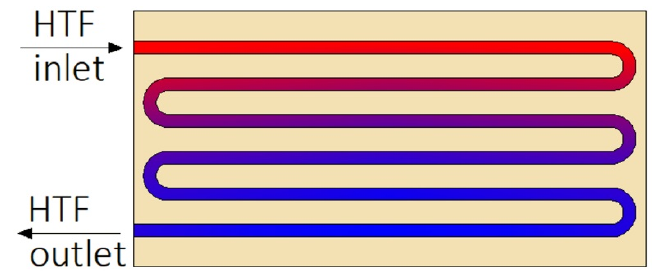
Figure 16. An example of the other type of heat exchanger.